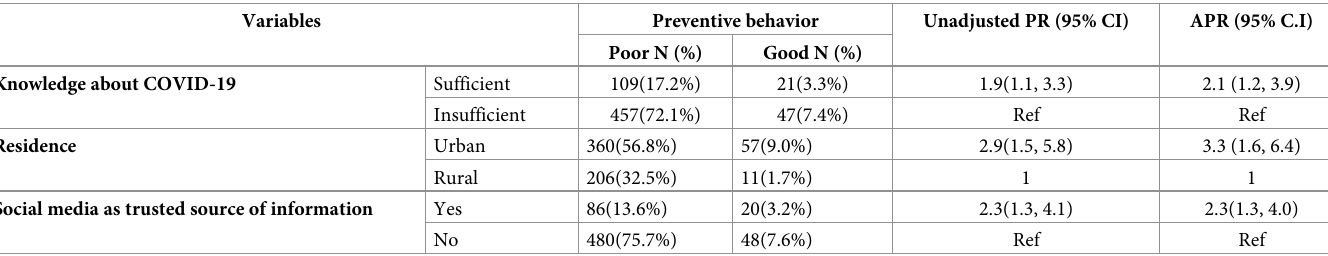
Table 5. Factors associated with COVID-19 preventive behavior in Qellam Wallaga Zone, Oromia, Ethiopia,